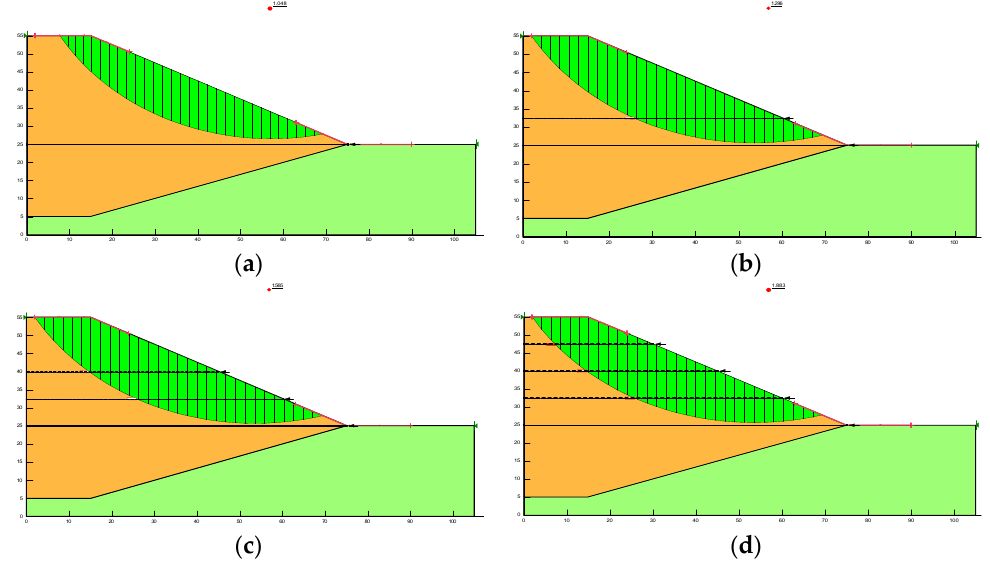
Figure 14. ( a ) N = 1; ( b ) N = 2; ( c ) N = 3; ( d ) N = 4. Slip surfaces of the reinforced slope obtained by LEM analysis.